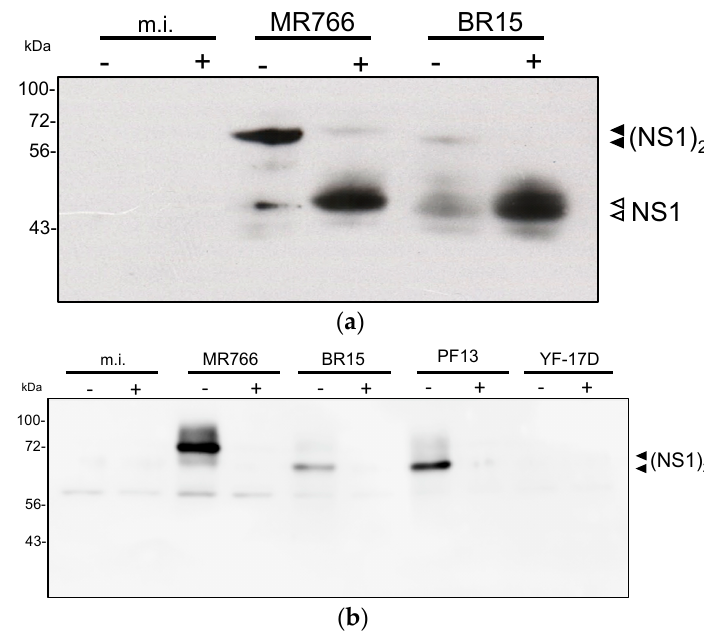
Figure 6. Reactivity of rat anti-rNS1 immune serum against ZIKV NS1 protein. RIPA lysates obtained from Vero cells infected with ZIKV strains MR766, BR15, and PF-25013-18 (PF13) or live-attenuated YFV 17D vaccine (YF-17D) or mock-infected (m.i.) were incubated with anti-NS1 1-151 ( a ) or anti-rNS1; ( b ) immune serum (dilution 1:500 and 1:1000 respectively) by immunoblot assay. The samples were heat denatured (+) or not ( − ) before immunoblot analysis. To the right of the blot, the open head arrow indicates the position of the NS1 monomer, and the black head arrow indicates the position of the NS1 dimer. The molecular weight (MW) of protein size markers is indicated to the left of the blot.